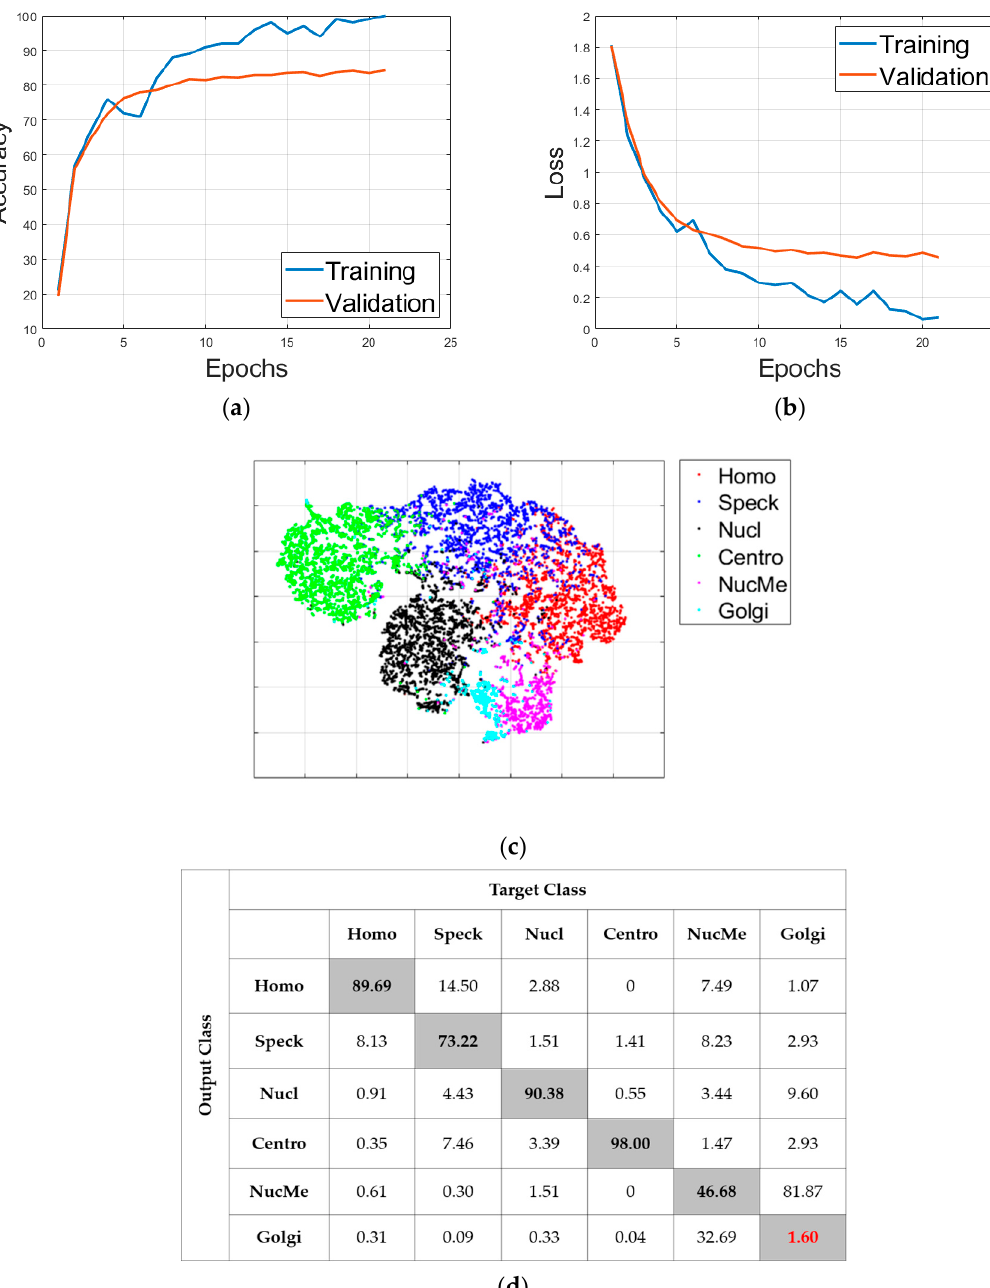
Figure 11. Classification results of the “RS” case: ( a ) accuracy, ( b ) loss, ( c ) features’ visualization and ( d ) confusion matrix.